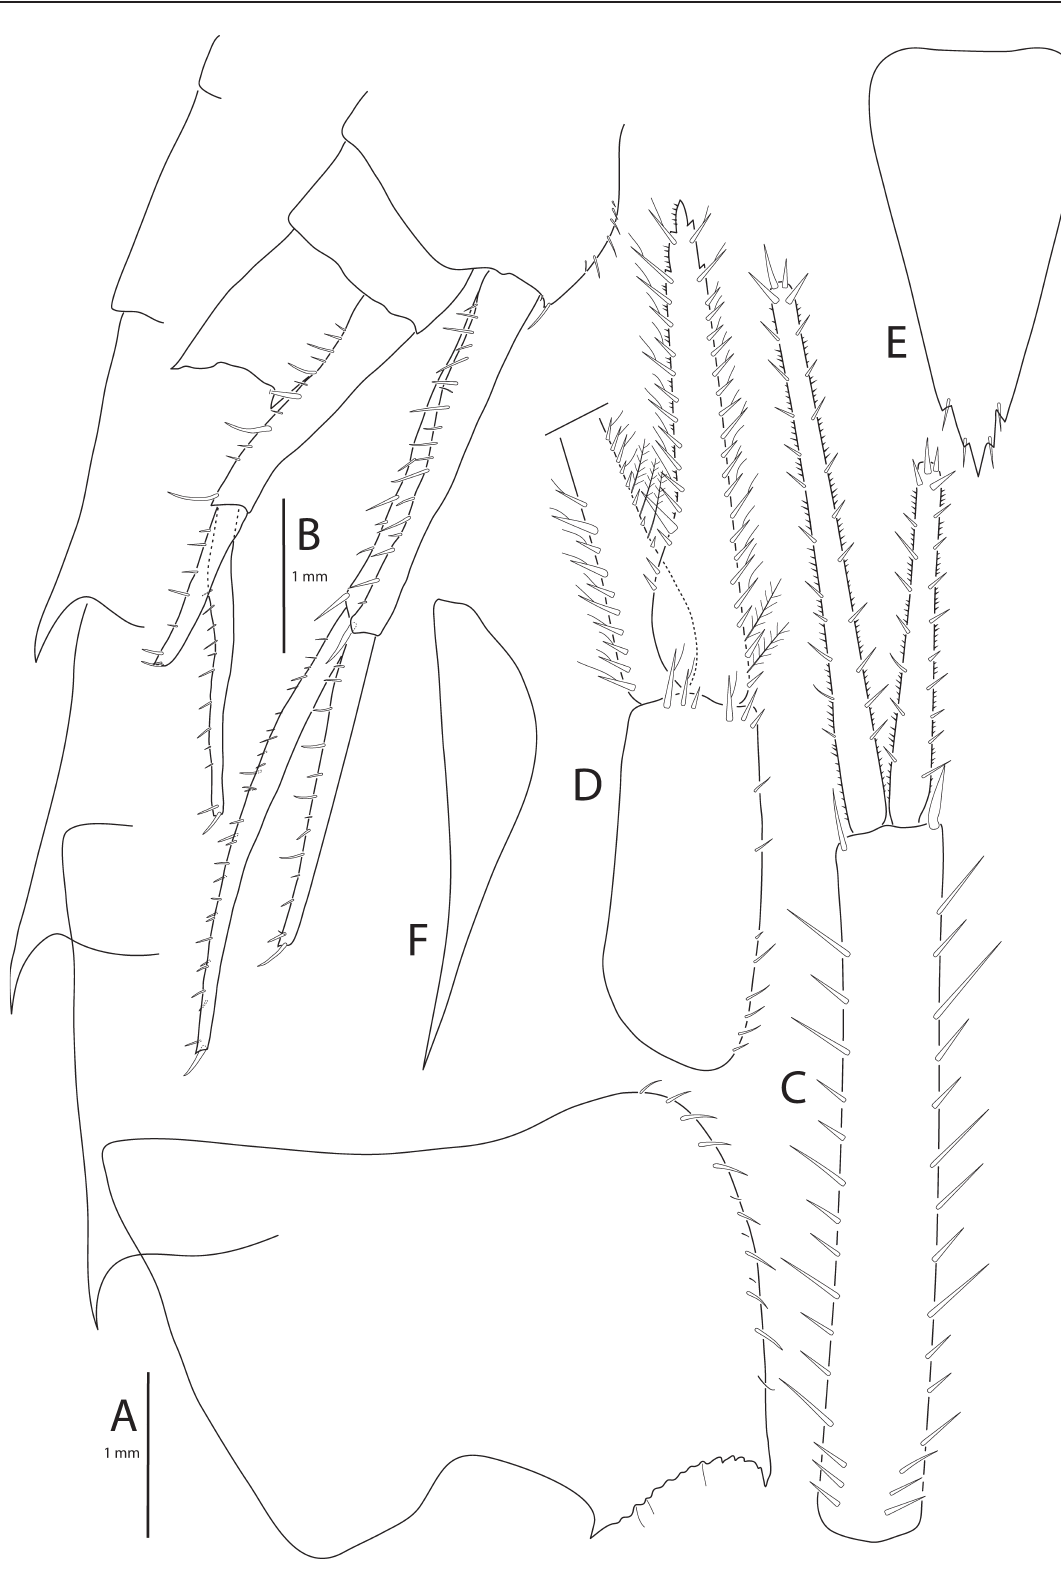
Fig. 12. Halirages stappersi sp. nov., holotype ♂, 20 mm, Kara Sea, RV Belgica stn 132. A-B . original; C-F . after Stappers (1911). A . medium part of body. B . urosome and right U1 and U2. C . left U1. D . left U3. E . telson in dorsal view. F . telson in lateral